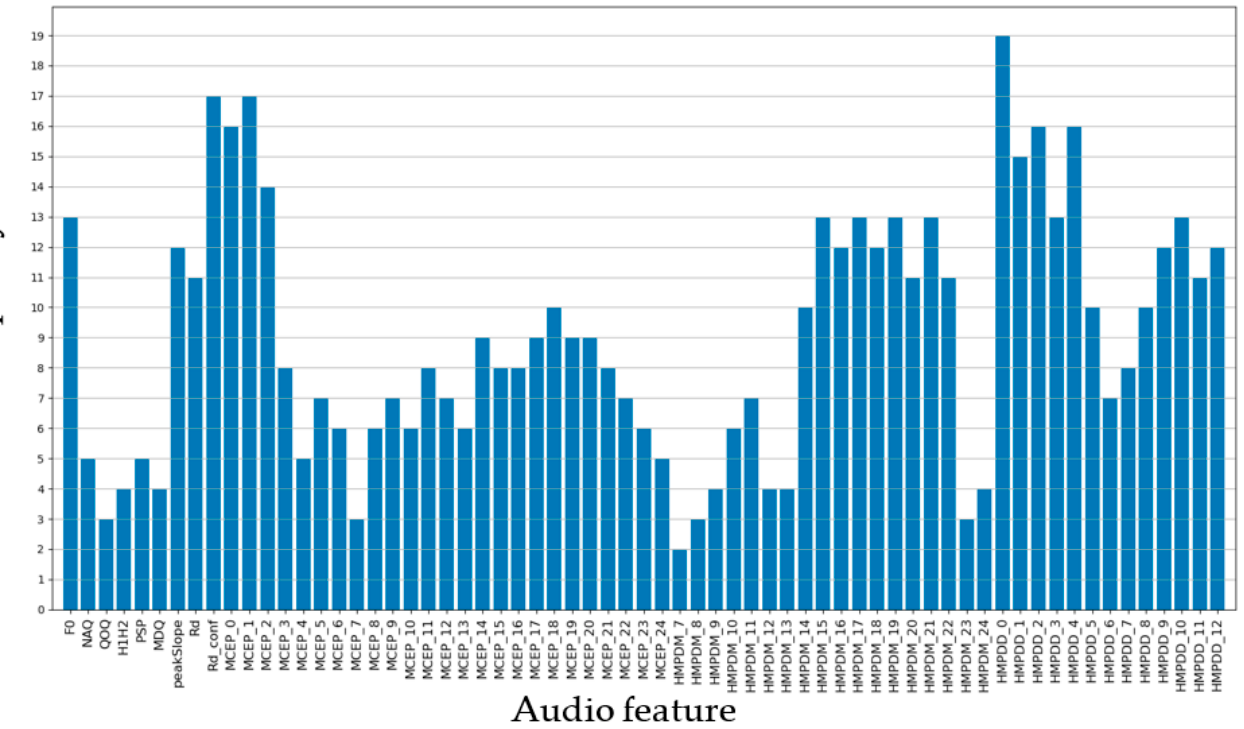
Figure 4. Number of times selected as the neighborhood for each audio feature.